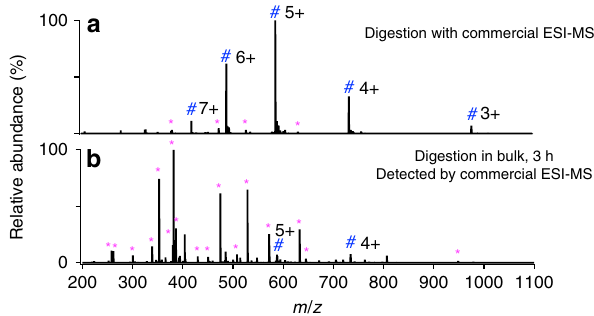
Fig. 3 Comparison of ACTH digestion with various methods. a commercial ESI-MS (LTQ Orbitrap Elite, Thermo Scienti fi c), b bulk phase at 37 °C for 3 h, followed by analysis with commercial ESI-MS. The 16 peptide peaks found in b are listed in Supplementary Table 2. Magenta asterisks denote the peptide fragments, and blue #s mark undigested ACTH peaks. The unassigned peaks could be peptide adduct ions with solvent or background solvent peaks.